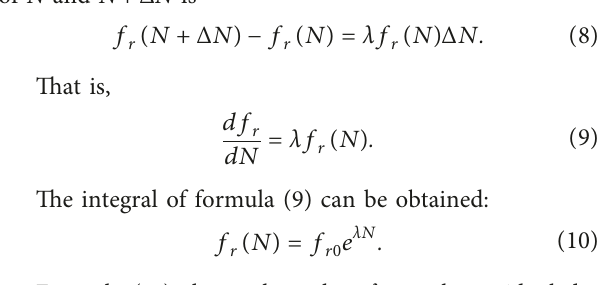
1 and freeze-thaw cycles n